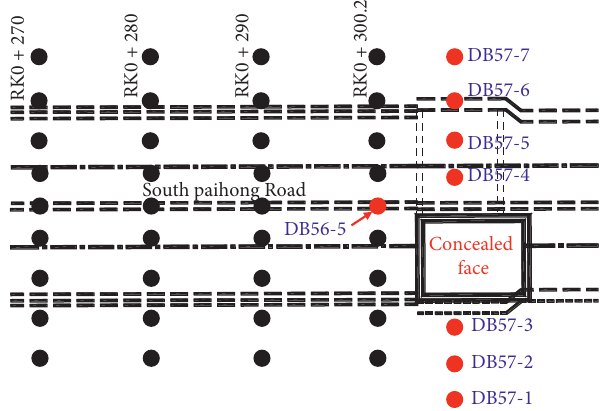
Figure 20: Vertical shaft surface monitoring